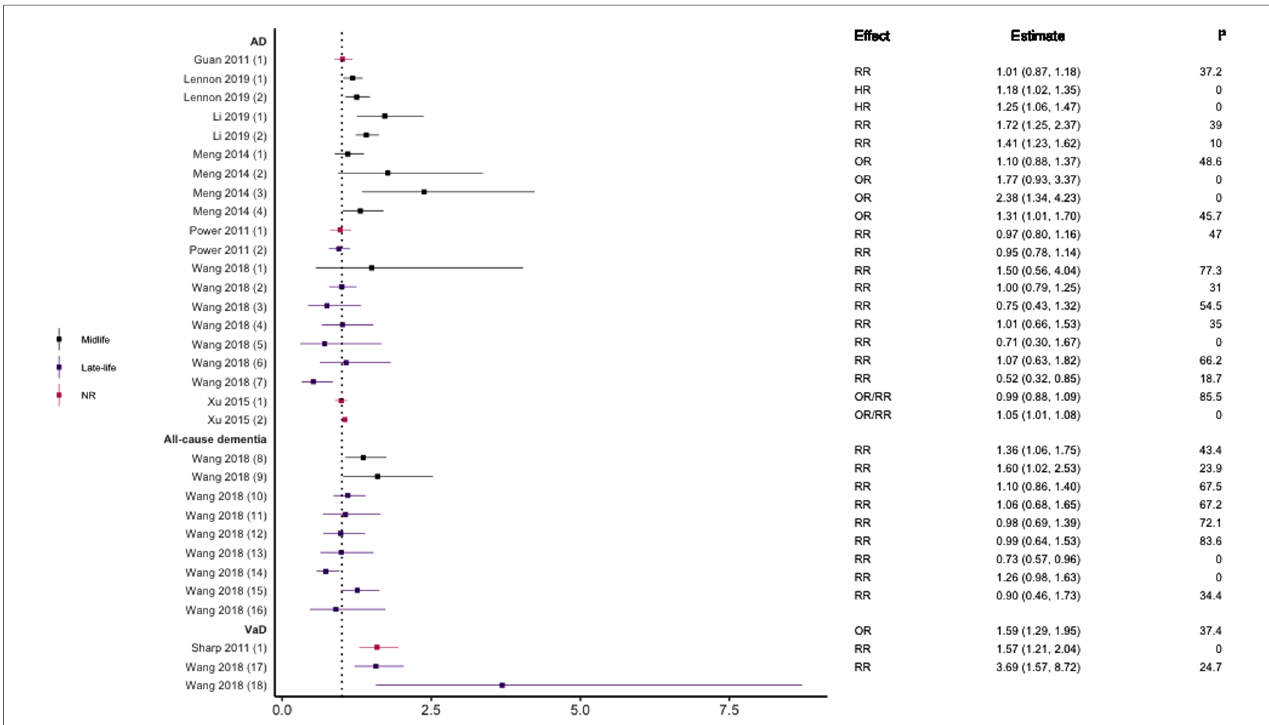
FIGURE 5 Effect estimates of meta-analyses reporting an association between hypertension (various de fi nitions) and dementia. The vertical line represents no effect, with distinct colours conveying age strati fi cation. To note, Xu et al. treated ORs as approximates to RRs, as such, violations of this assumption may have implications for the comparability of ORs and RRs, meaning that interpretation of these pooled estimates should be done cautiously. AD, Alzheimer ’ s disease; HR, hazard ratio; NR, not reported; OR, odds ratio; RR, risk ratio; VaD, vascular